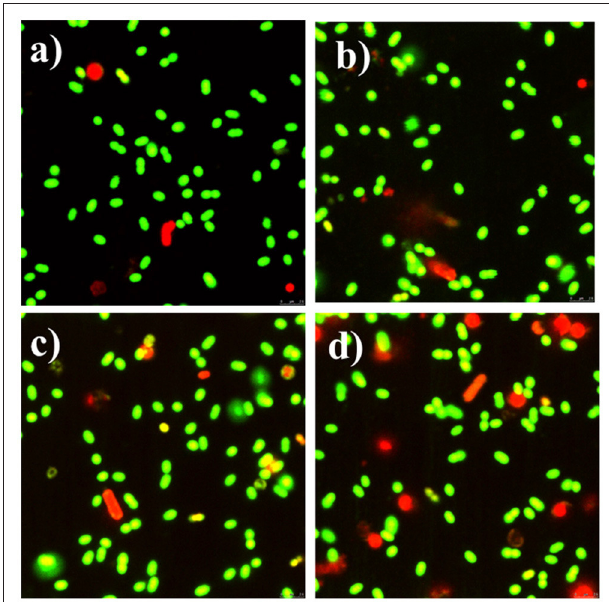
FIGURE 8 | Fluorescence microscope of apoptotic and necrotic cells before (a) and after exposure to CCNPs (b) , GS (c) , and CGPs (d) . Briefly, 0.1 g/L sample was added to the bacterial suspension for 12h. All stained samples were imaged at a comparable cell concentration.